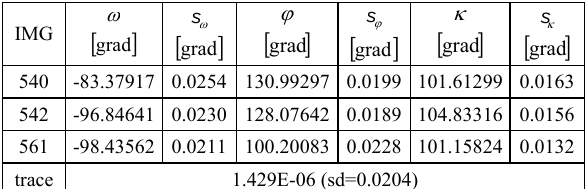
Table 5. The angular exterior parameters of images and standard deviation